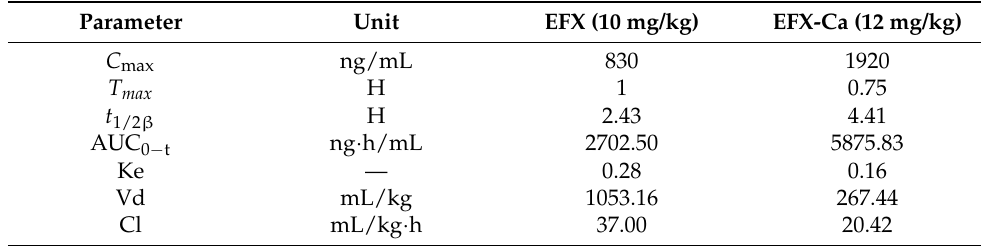
Figure 5. The relationship between drug concentration and the elimination time in plasma samples from the tested SD rats treated with EFX-Ca and EFX at different time points (0, 0.083, 0.333, 0.5, 0.75, 1, 3, 4, 6, 8, 10, 12, and 24 h). Table 5. Main pharmacokinetic parameters of the plasma sample from the tested SD rats under the oral administration of EFX and EFX-Ca, respectively.